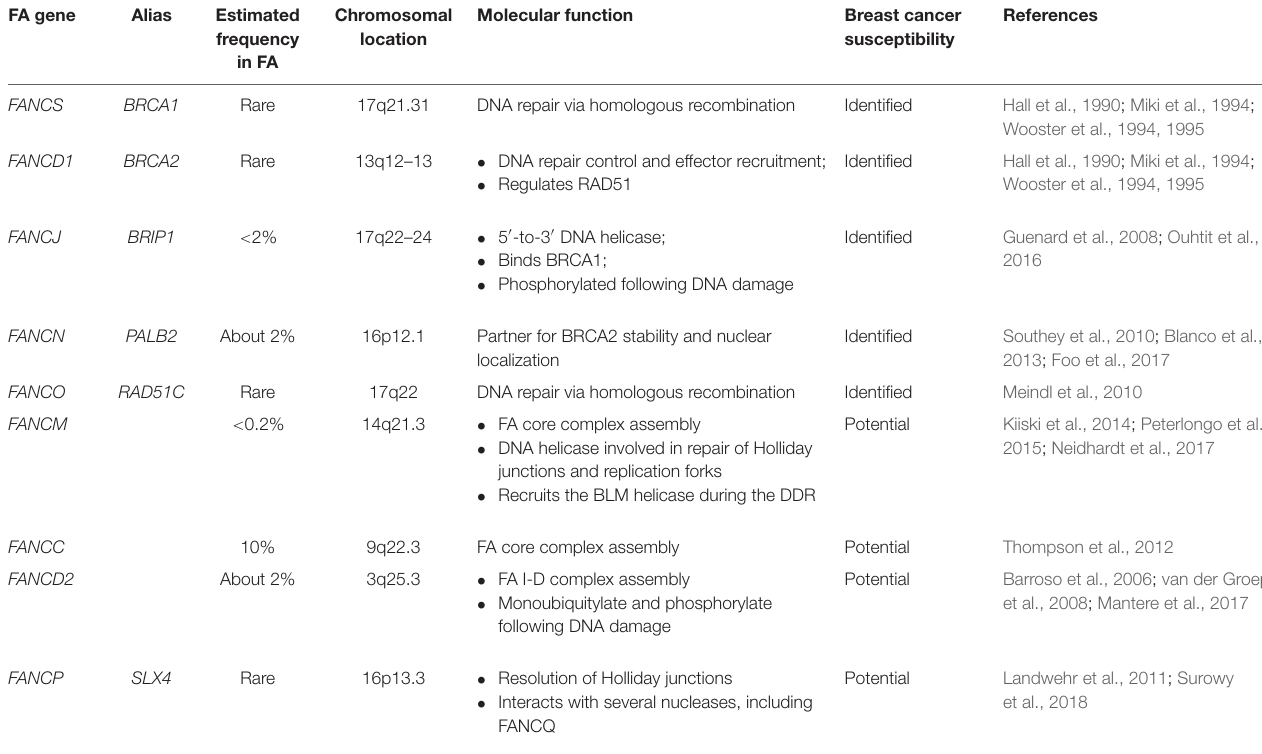
TABLE 1 | Classification of FA genes that confer to breast cancer susceptibility. FA